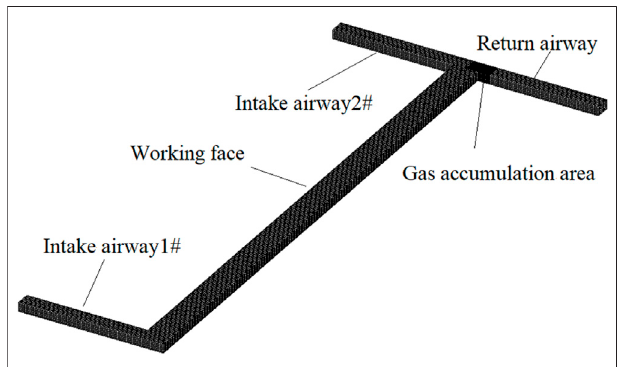
FIGURE 1 | Three-dimensional physical model of Y-type